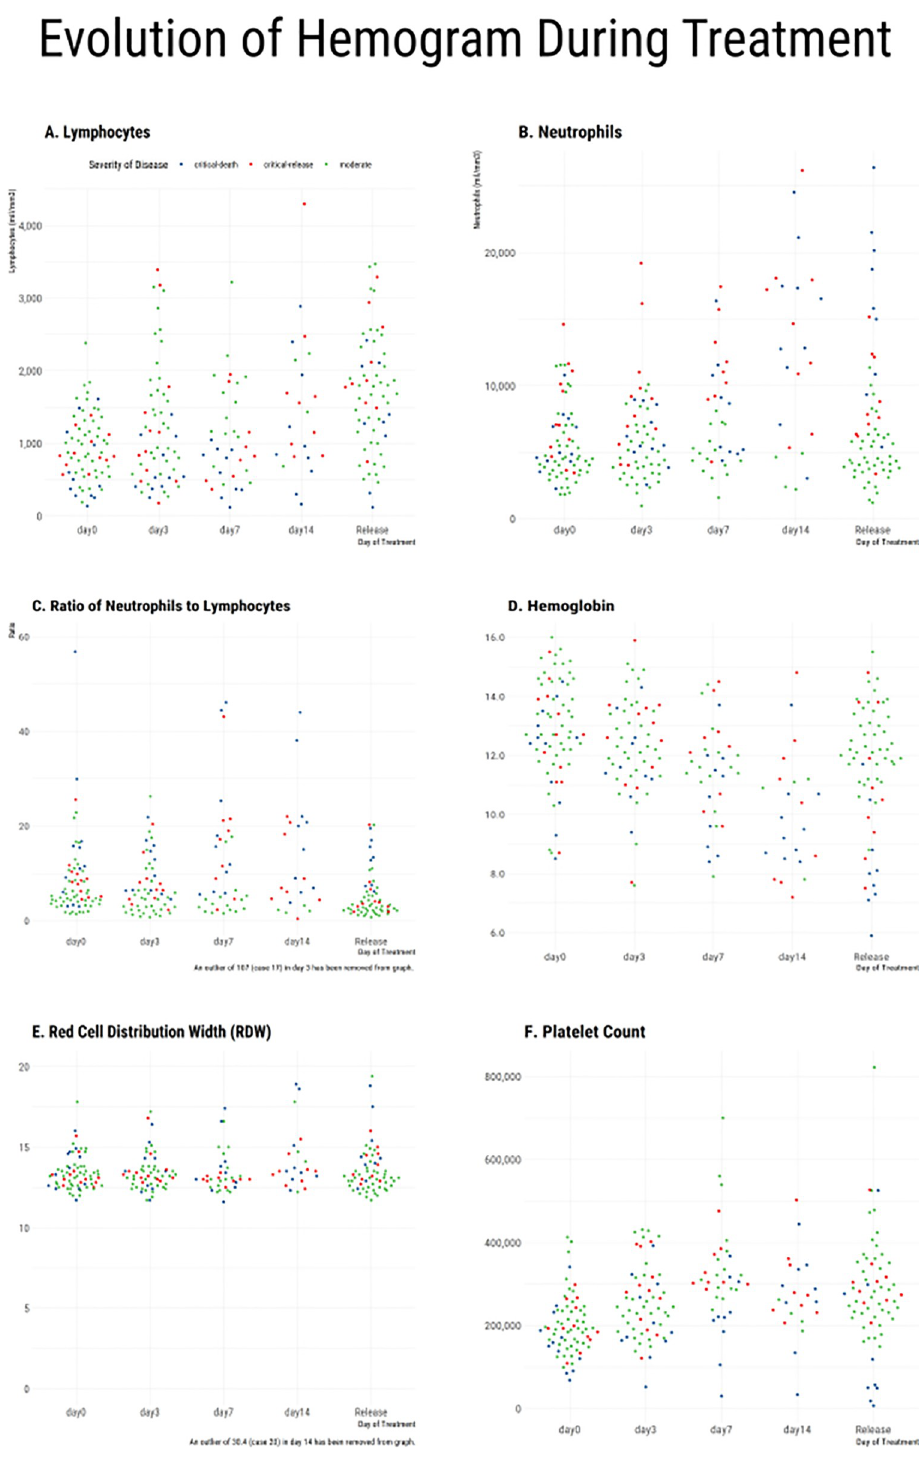
Fig 1. Hematologic laboratory tests segregated accordingly to the clinical course (moderate and critical) and outcomes (survivors and non-survivors). Lymphocytes (A), neutrophils (B), neutrophils to lymphocytes ratio (C), hemoglobin (D), RDW (E), and platelets